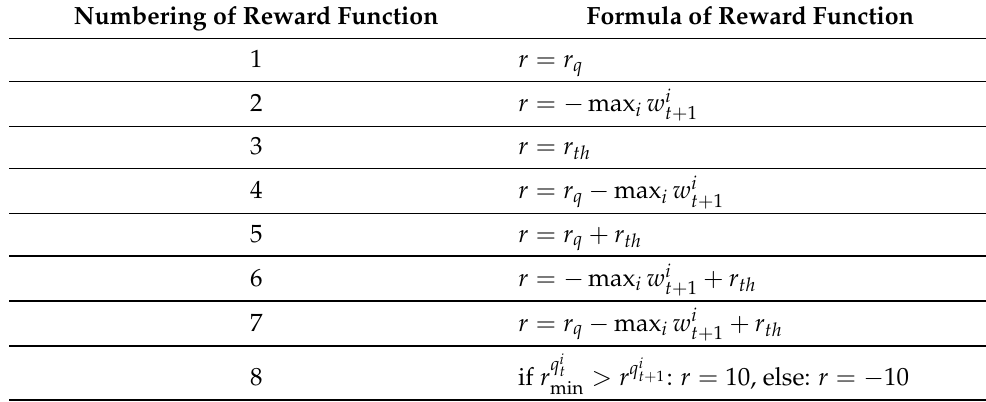
Table 2. Combination of reward functions used for training.